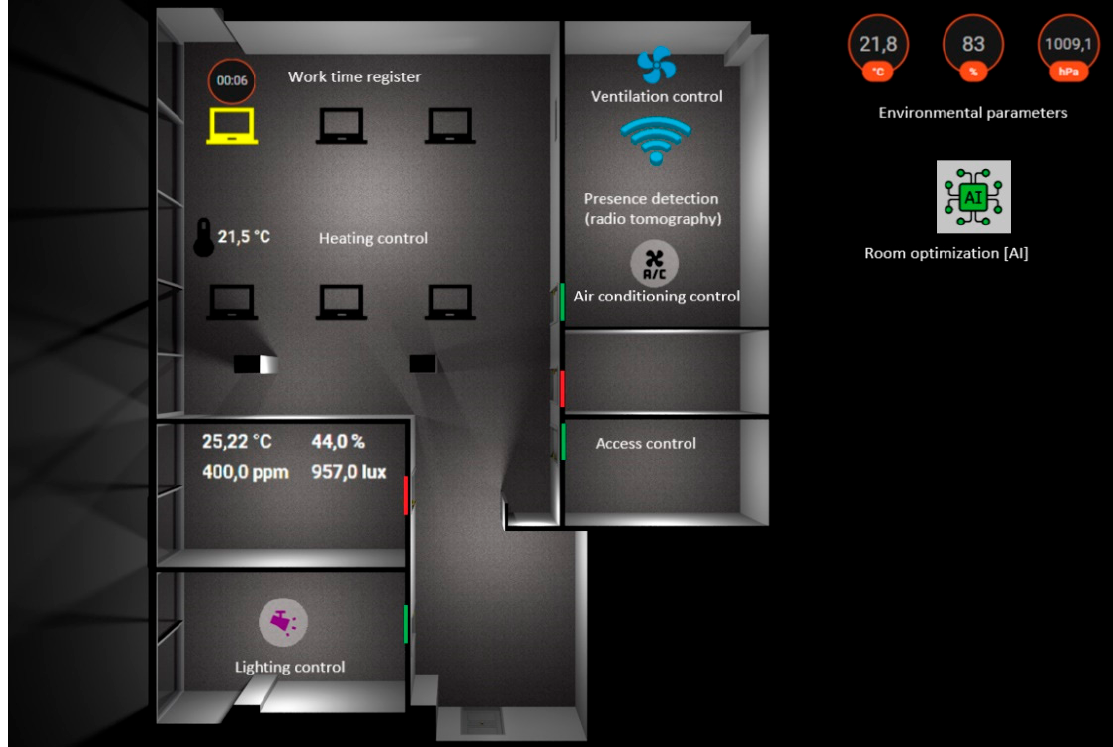
Figure 20. Presence detection system panel designed by CBRTI Sp. z o.o. Research and Development Center.